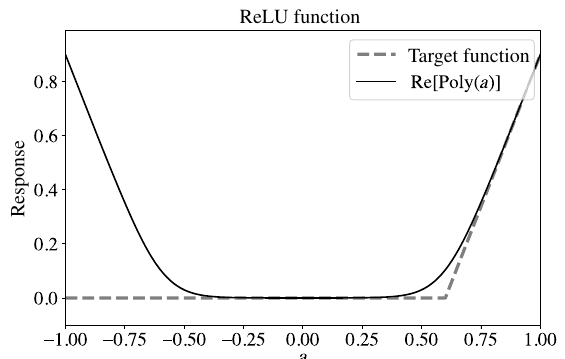
FIG. 31. The response function for the polynomial approxima- tion to the ReLU function with δ = 0.6 and (cid:16) =